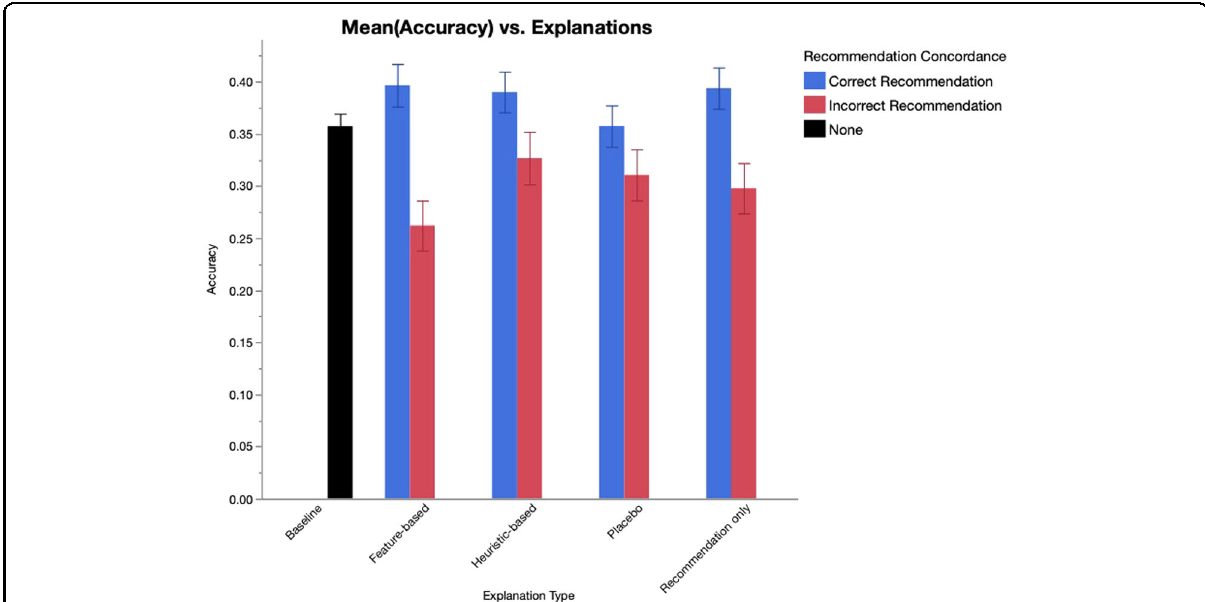
Fig. 2 Changes in mean treatment selection accuracy by explanation type for the baseline, correct, and incorrect recommendation conditions. Error bars show standard